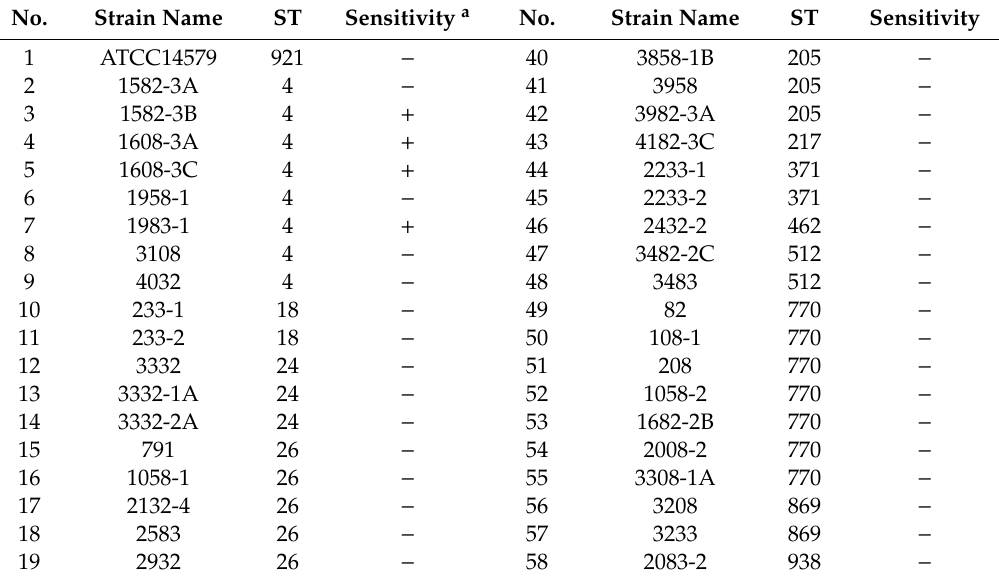
Figure 6. Stability of DLc1 under di ff erent environmental stresses, including ( A ) temperature (statistical significance is done by comparing the value of each temperature with that of 4 ◦ C); ( B ) pH (statistical significance is done by comparing the value of each pH with that of pH 7); ( C ) NaCl concentration (statistical significance is done by comparing the value of each concentration with that of 0 mM); ( D ) ethanol concentration (statistical significance is done by comparing the value of each concentration with that of 0%); ( E ) mechanical vortex and the existence of chloroform. 5 # represents the vortex time of 5 s followed by sitting at 4 ◦ C for 24 h (statistical significance in mechanical vortex without chloroform is done by comparing the value of di ff erent vortex time to that of control, and in the condition with chloroform, statistical significance is done by comparing the value of di ff erent vortex time to that of 5 s; statistical significance is also compared between values with and without chloroform in 5 #). Means and standard deviations (SD) of three independent assays are shown. Asterisks indicate significant di ff erences (** p ≤ 0.01 and *** p ≤ 0.001), and ns represents no significant di ff erence.